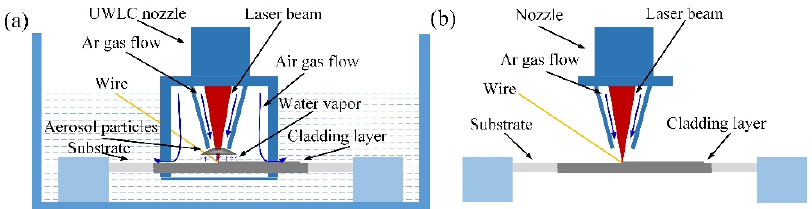
Figure 2. The schematic diagram of underwater and in-air laser cladding processes: ( a ) the underwater laser cladding process; ( b ) the in-air laser cladding process.